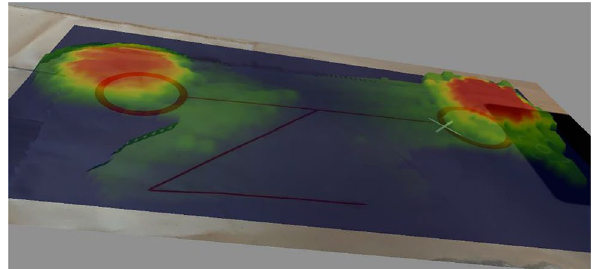
Figure 6. Textile dual-band (NFC-A4WP) combiner electromagnetic field emission cartography.